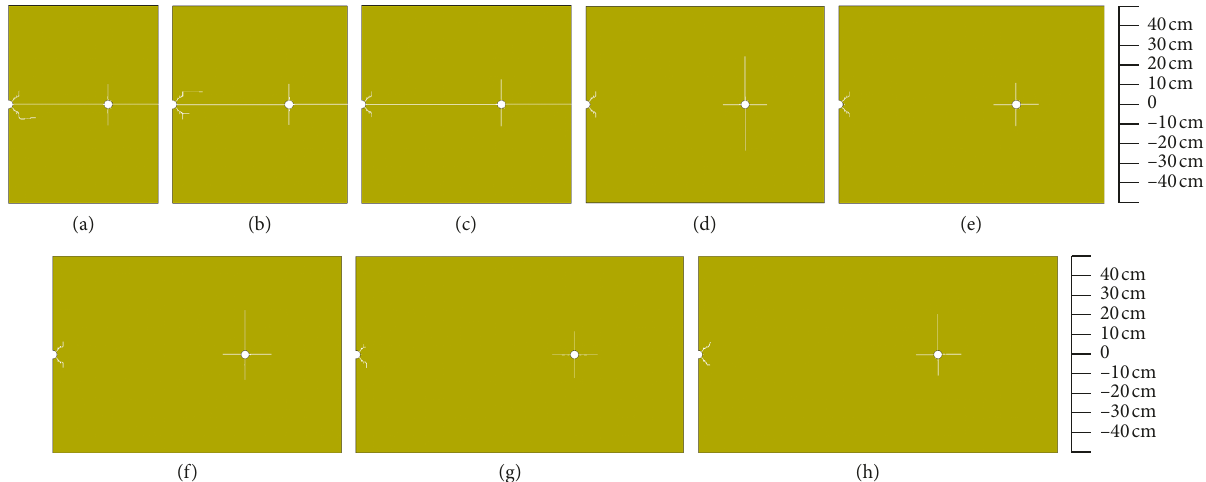
Figure 18: Cracks formation diagram under different blast hole spacing when PBH is a round hole. (a) H � 50cm. (b) H � 60cm. (c) H � 70cm. (d) H � 80cm. (e) H � 90cm. (f) H � 100cm. (g) H � 110 cm. (h) H � 120cm.